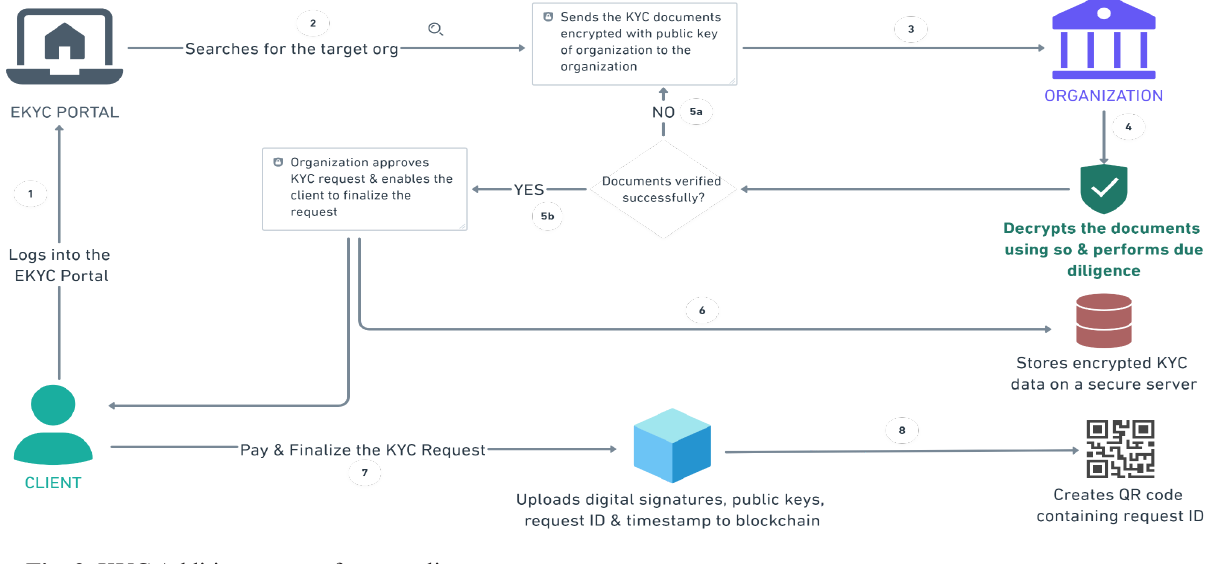
Fig. 3 . KYC Addition process for new